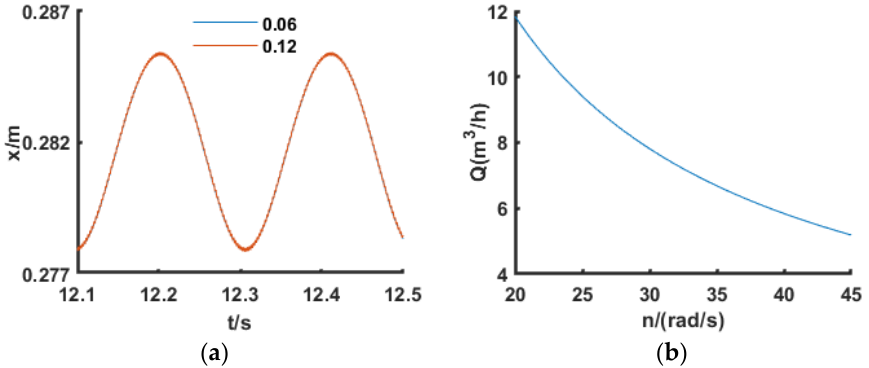
Figure 7. Actual results of influence parameters: ( a ) Displacement of revolute joint B at different clearance sizes; ( b ) Relationship between eccentric shaft speed and production capacity.